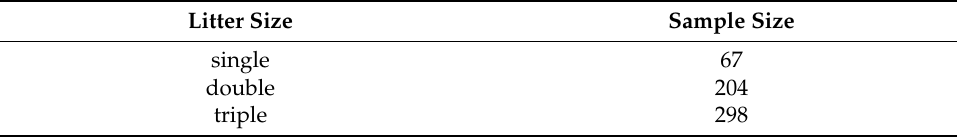
Table 1. Phenotypic distribution of female goats with different litter sizes. Litter Size Sample Size single 67 double 204 triple